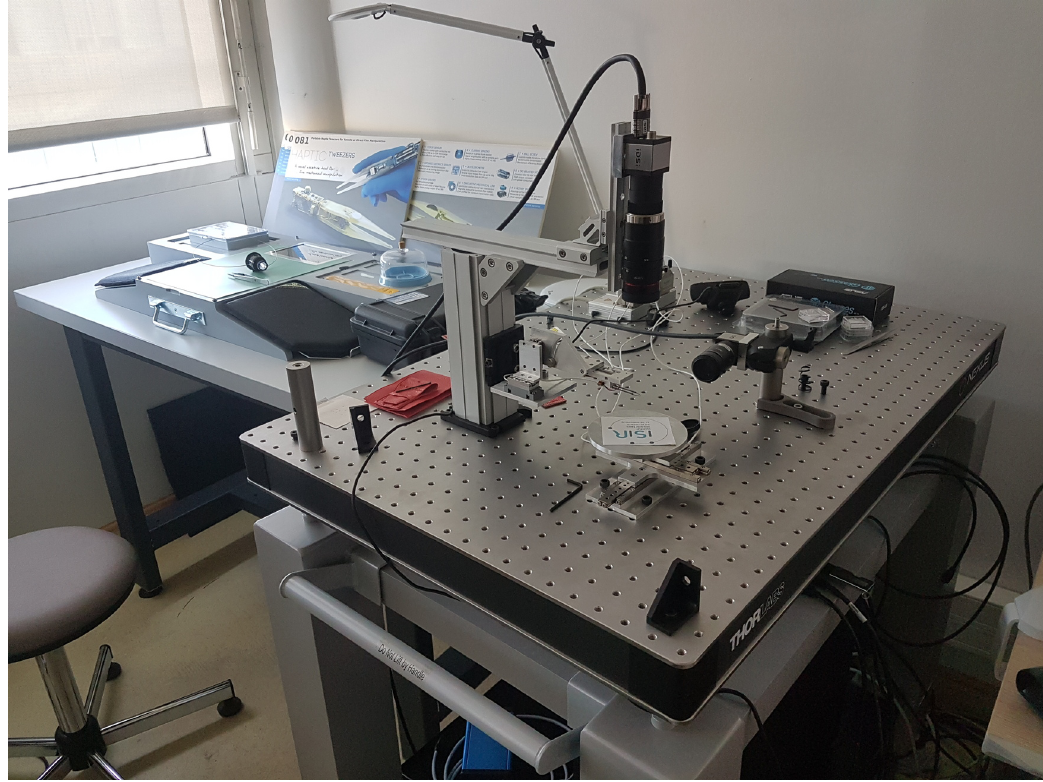
Fig. 6. The assembling robotic